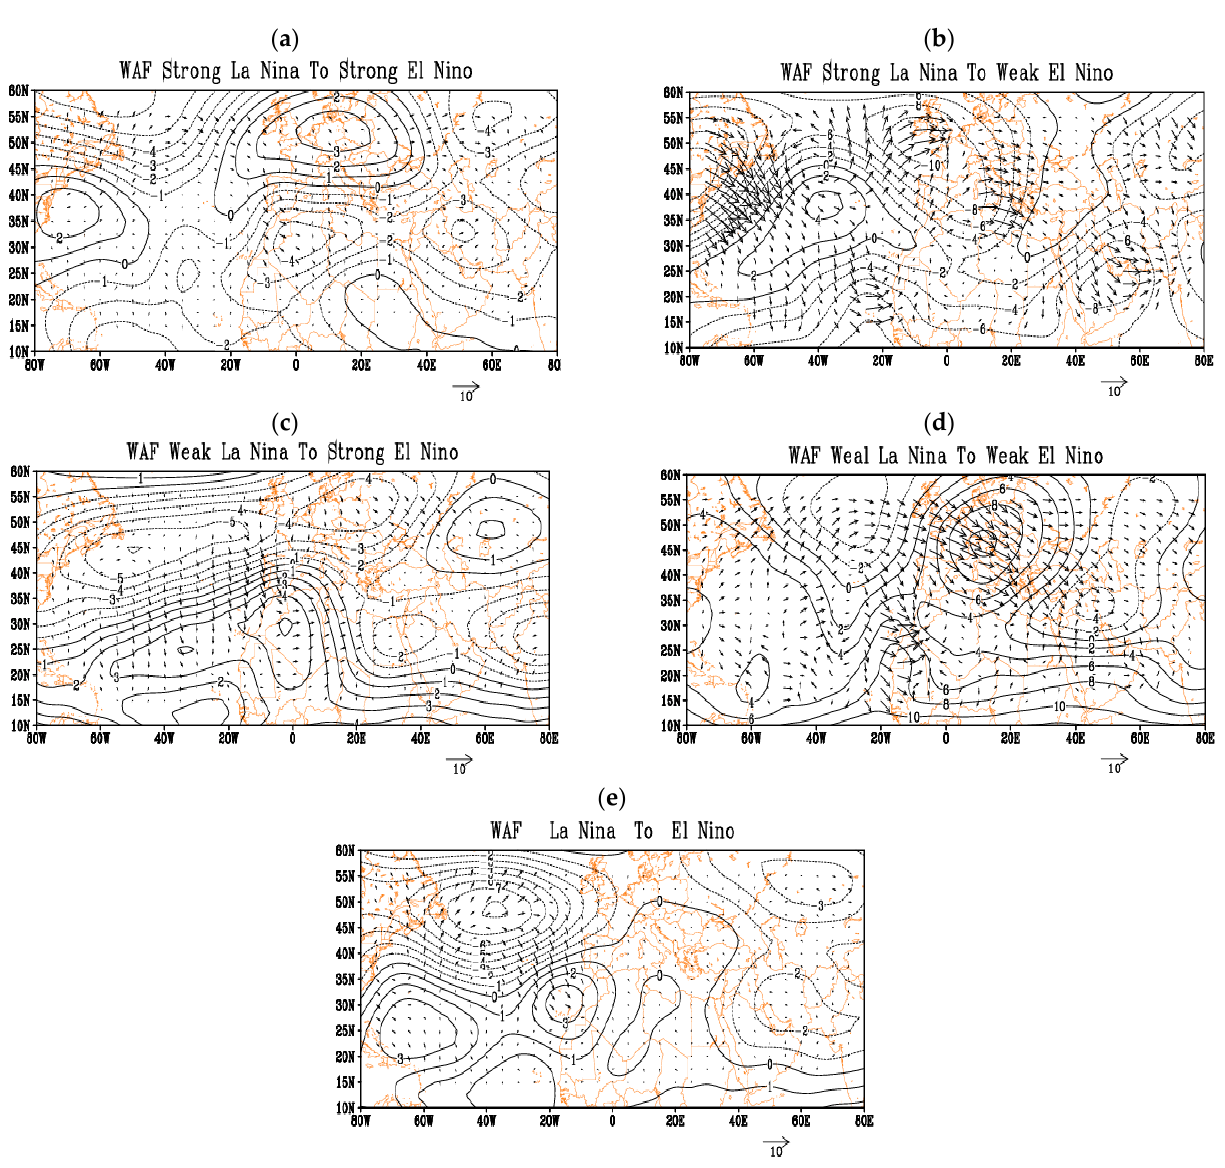
Figure 4. Same as Figure 3, but for type 2 transition years.